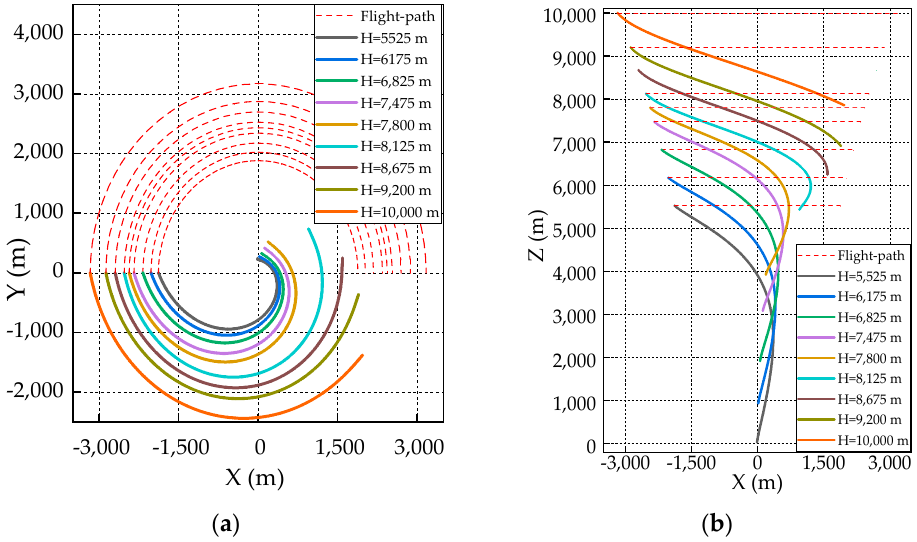
Figure 14. Towline spatial configurations vs. orbit altitude: ( a ) Two-dimensional projection in horizontal plane. ( b ) Two-dimensional projection in vertical plane.